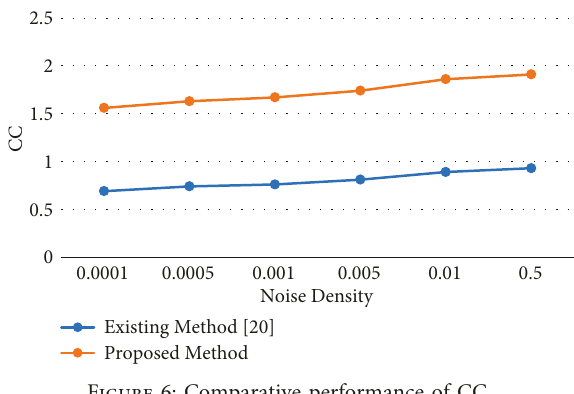
Figure 6: Comparative performance of